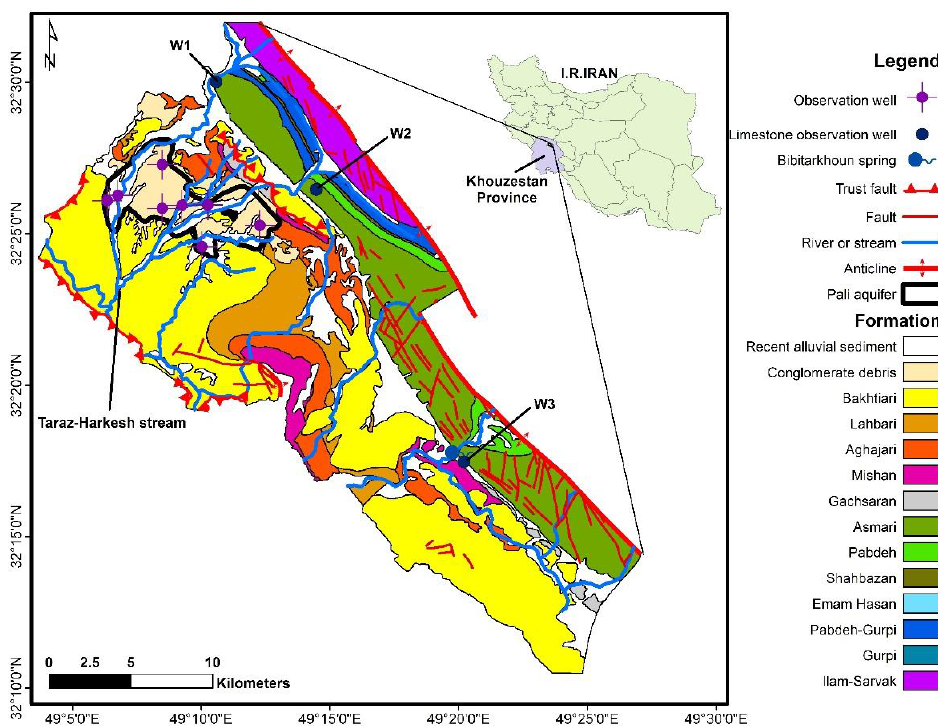
Figure 1. The Lali region, its geological formations and water resources, i.e., the Pali alluvial aquifer, the Taraz-Harkesh stream, the Bibitarkhoun karst spring and the karst wells (W1, W2 and W3). The study area is located in the southwestern ridge of the Gurpi and Pabdeh anti- clines. Formations in the study area are Ilam-Sarvak (limestone), Gurpi (shale), Imam Hassan (limestone), Shahbazan (limestone and dolomite), Pabdeh (shale), Asmari